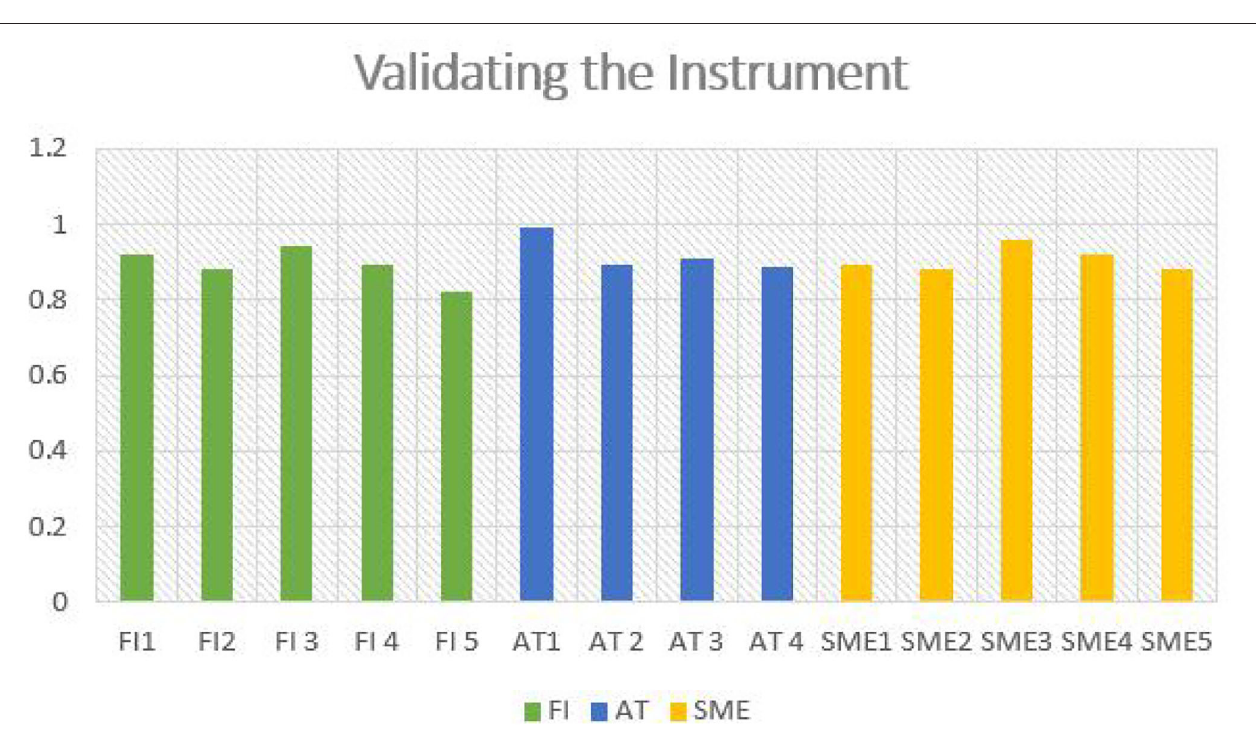
FIGURE 3 | Graphical representation of validating the instrument used in the study.